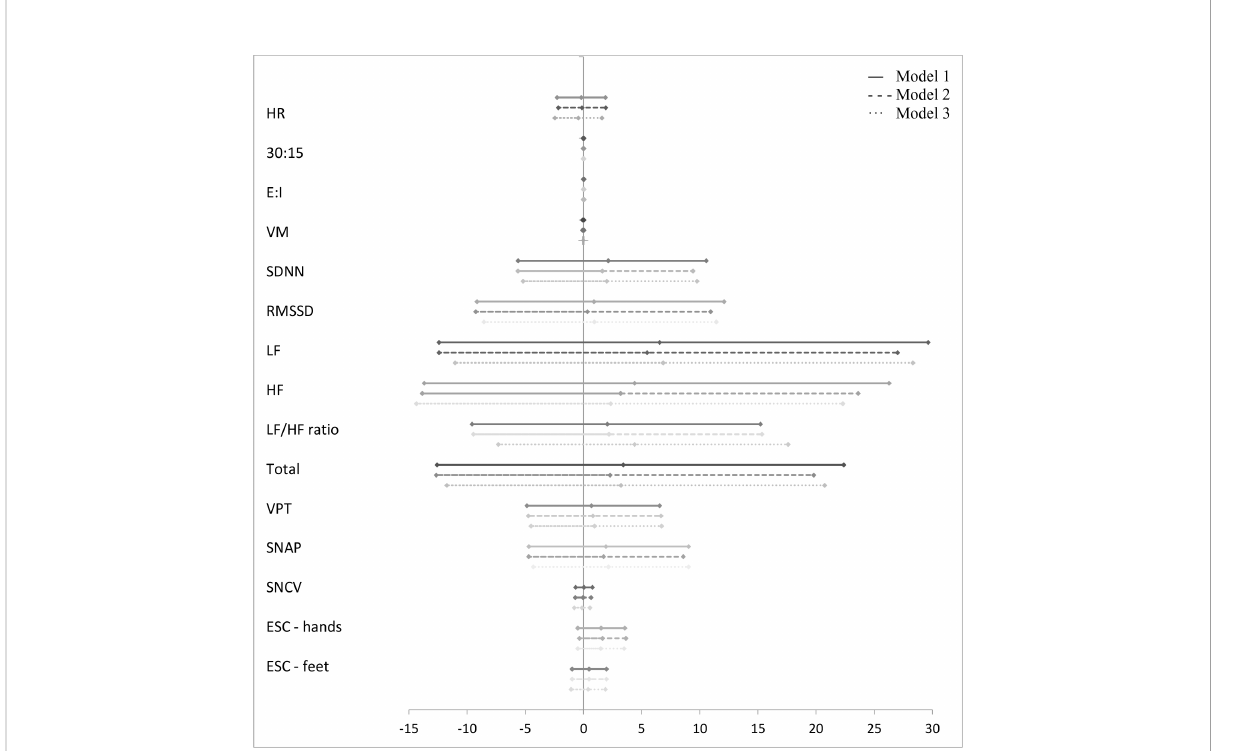
FIGURE 3 Forest plot of the associations between “ glucotoxicity ” and measures of diabetic neuropathy. Results are presented as estimates and 95% con fi dence intervals. Estimates show the percentage change in the outcomes for an increase of one unit of “ glucotoxicity ” . Studies with con fi dence interval crossing the vertical line are inconclusive. Model 1 adjusted for age and gender, model 2 adjusted as model 1 + diabetes duration and HbA 1c , and model 3 adjusted as model 2 + current smoking, total cholesterol, triglycerides, systolic blood pressure, and the use of beta blockers. CAN, cardiovascular autonomic neuropathy; HR, heart rate; 30:15, lying-to-standing test; E:I, deep breathing test; VM, Valsalva Manoeuvre; SDNN, standard deviation of normal-to-normal intervals; RMSSD, root mean square of the sum of the squares of differences between consecutive R-R intervals; LF, low-frequency power; HF, high-frequency power; DSPN, distal symmetric polyneuropathy; VPT, vibration perception threshold; SNAP, sural nerve amplitude potential; SNCV, sural nerve conduction velocity; ESC, electrochemical skin conduction. *p <